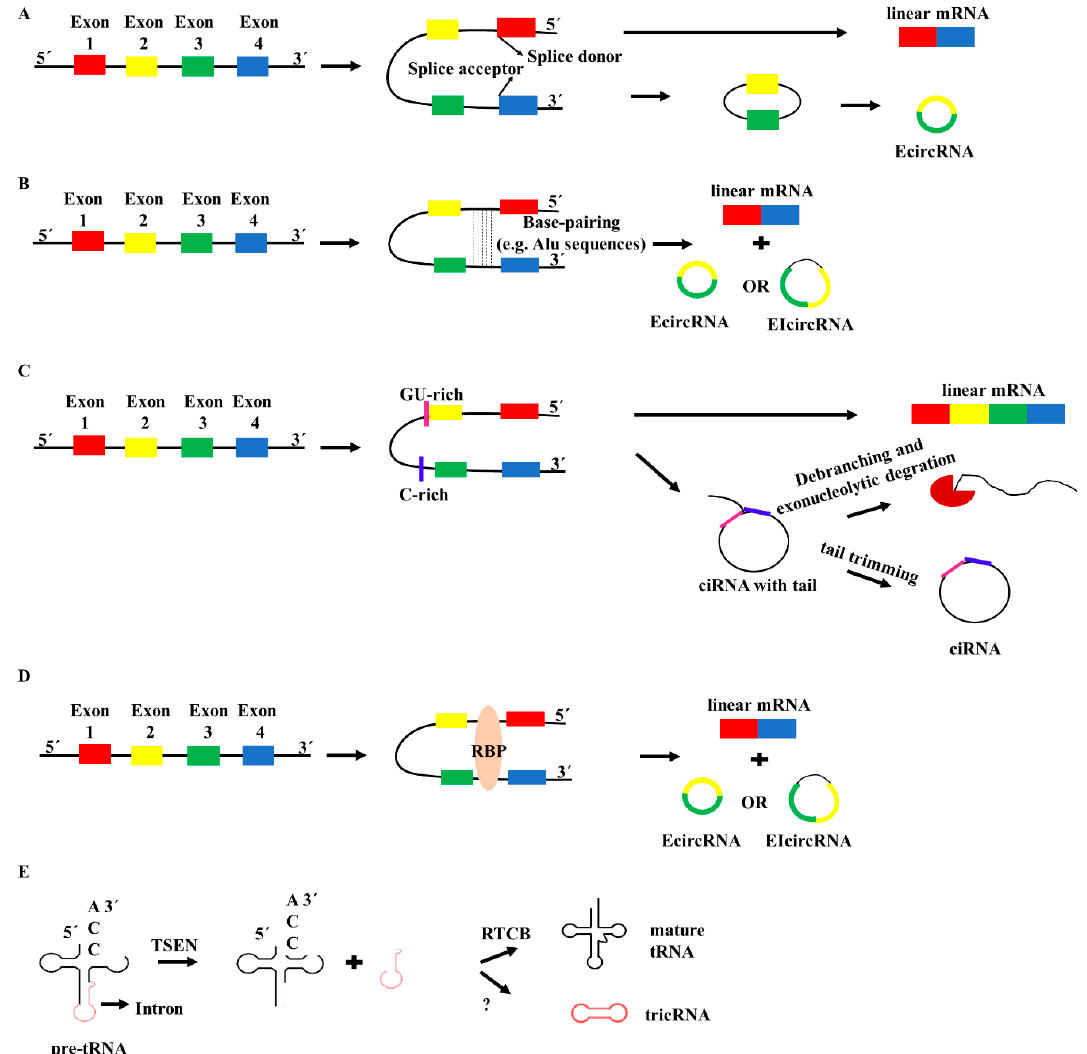
Figure 1. The proposed models for circular RNA (circRNA) biosynthesis. ( A ) Lariat-driven circularization or exon skipping. The pre-mRNA folds partially, encouraging the attack of the 5’ splicing site (splice donor) of the upstream intron to the 3’ splicing site (splice acceptor) of the downstream intron. This back-splicing of the folded region generates the circRNA and the rest exons generate a linear mRNA. ( B ) Intron pairing-driven circularization. Flanking reverse complementary sequences at the introns (mostly Alu sequences) mediate back-splicing generating circRNAs, i.e., EcircRNAs and EIcircRNAs. ( C ) The biogenesis of intronic circRNAs necessitates a consensus motif composed of a 7-nt GU-rich element near the 5’ splice site and an 11-nt C-rich element near the branchpoint site. ( D ) RNA-binding proteins (RBPs), such as muscleblind-like splicing regulator 1 (MBNL1) and Quaking homolog KH domain RNA-binding (QKI) protein, bring closer the donor site and the acceptor site via binding the flanks of the introns and, hence, assist circularization. ( E ) circRNAs derive from pre-tRNAs (tricRNAs), as well. tRNA splicing endonuclease (TSEN) cleaves the pre-tRNA at specific sites. The RNA 2’,3’-cyclic phosphate and 5’-OH ligase (RTCB) is essential for the ligation of the tRNA exons, but the intron ligase for the generation of the tricRNA is unknown.